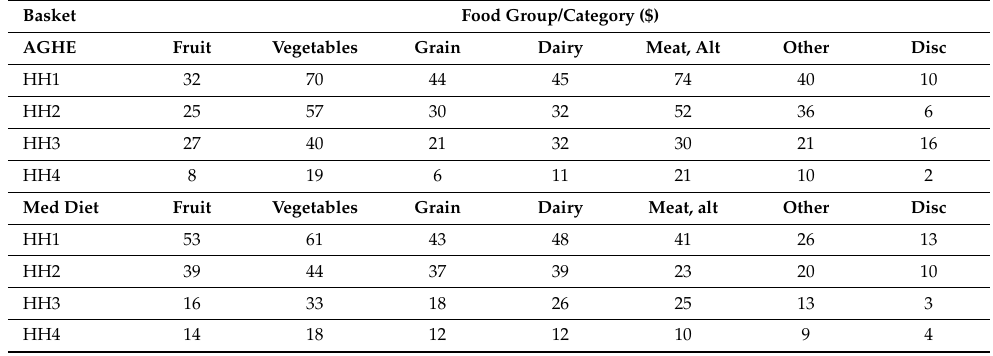
Table 11. Cost contribution of weekly food basket meal plan, not initial outlay, per AGHE food